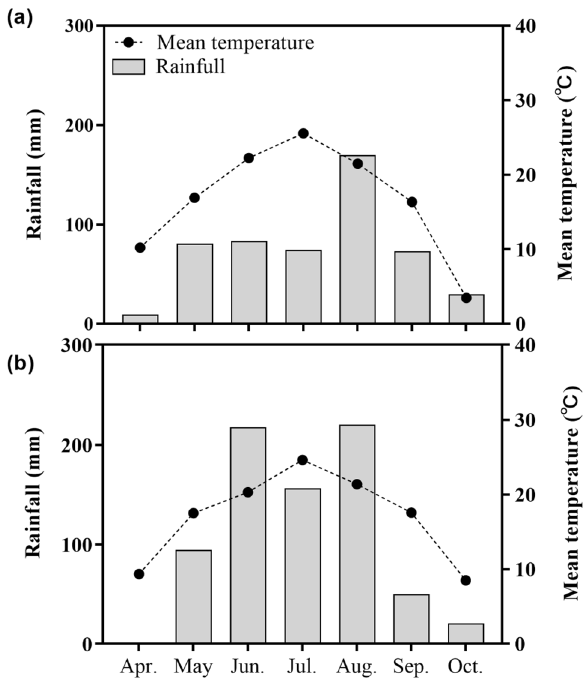
Figure 7. Rainfall and monthly mean temperature recorded during maize growing season (April to October) of experiment in 2018 ( a ) and 2019 ( b